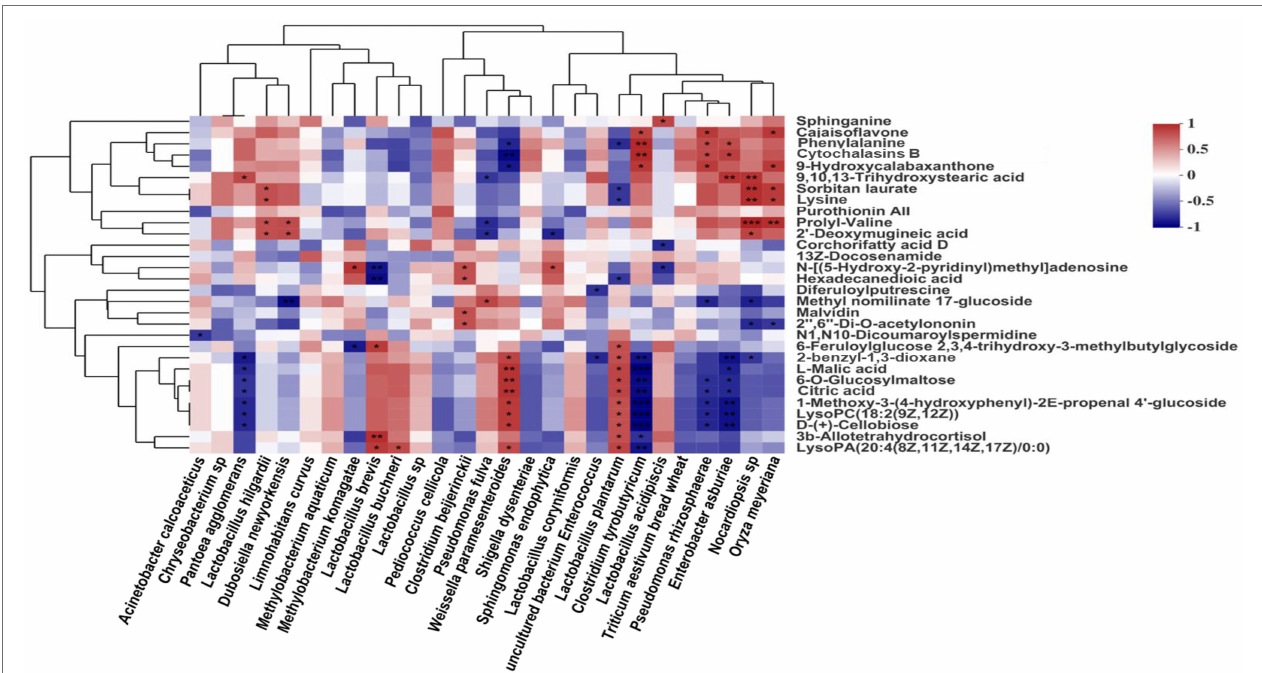
FIGURE 6 | Spearman’s correlations between main bacteria species and differentially presented metabolites in silage. Values of p are shown as *0.01 < p < 0.05 and ** p < 0.01. The corresponding value of the heat map is the Spearman’s correlation coefficient r , which ranges between − 1 and 1, r < 0 indicates a negative correlation (blue), r > 0 indicates a positive correlation